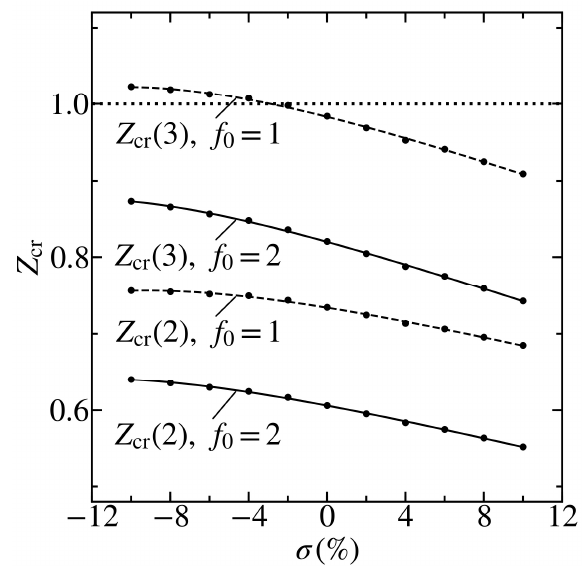
Figure 7. Dependence of the critical charge Z cr ( n ) on the mechanical tension σ for graphene on the h BN substrate. The lines are shown for the levels n = 2, 3 with the total angular momentum J = 0, and for the cuto ff function corresponding to the value f 0 = 2 (solid lines) and the rectangular cuto ff with f 0 = 1 (dashed lines). The cuto ff radius is equal to r 0 = 15Å. The circles correspond to the results calculated for ∆ and v D . The lines correspond to their least-squares quadratic fits (see Figures 3 and 4). The dotted line marks the closest integer value of the impurity charge Z = 1.